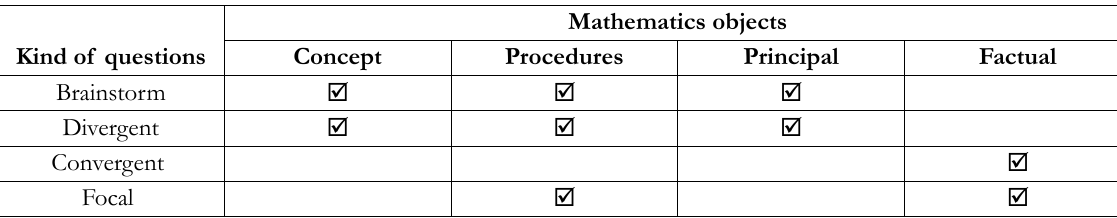
Table 3. The use of these types of questions in the learning of mathematical